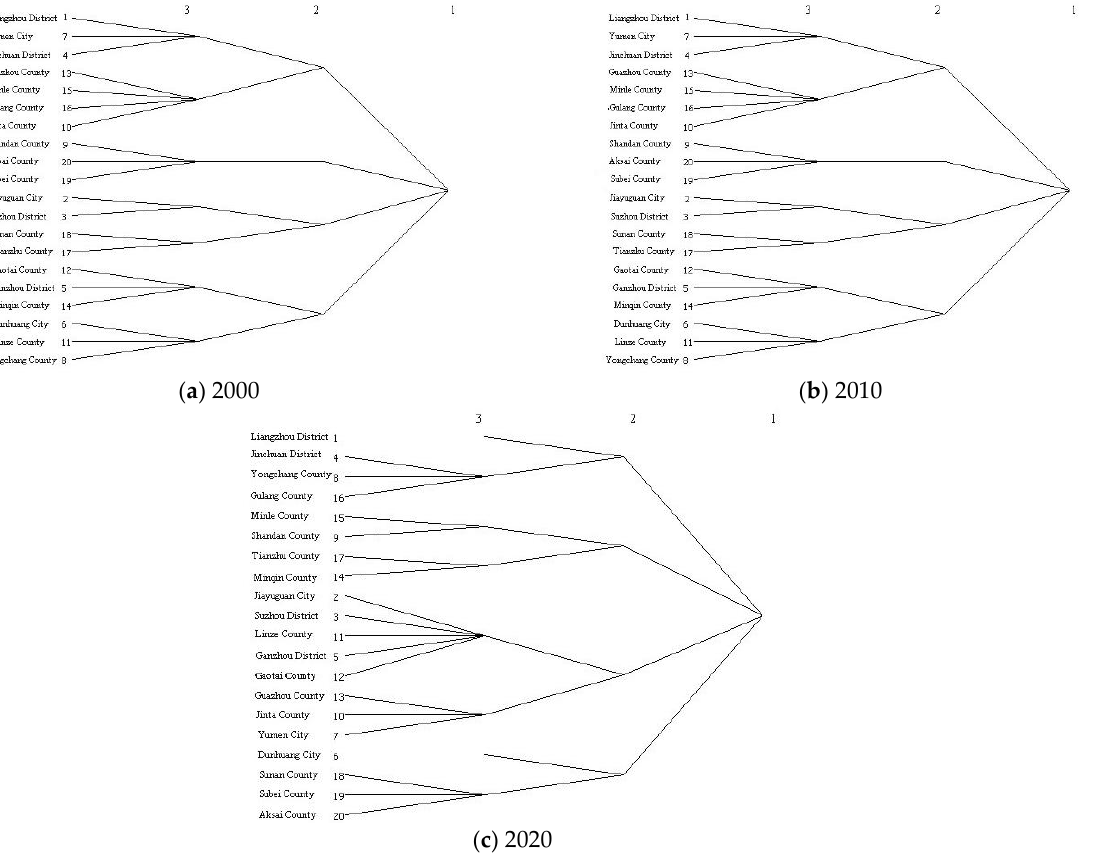
Figure 9. Cohesive